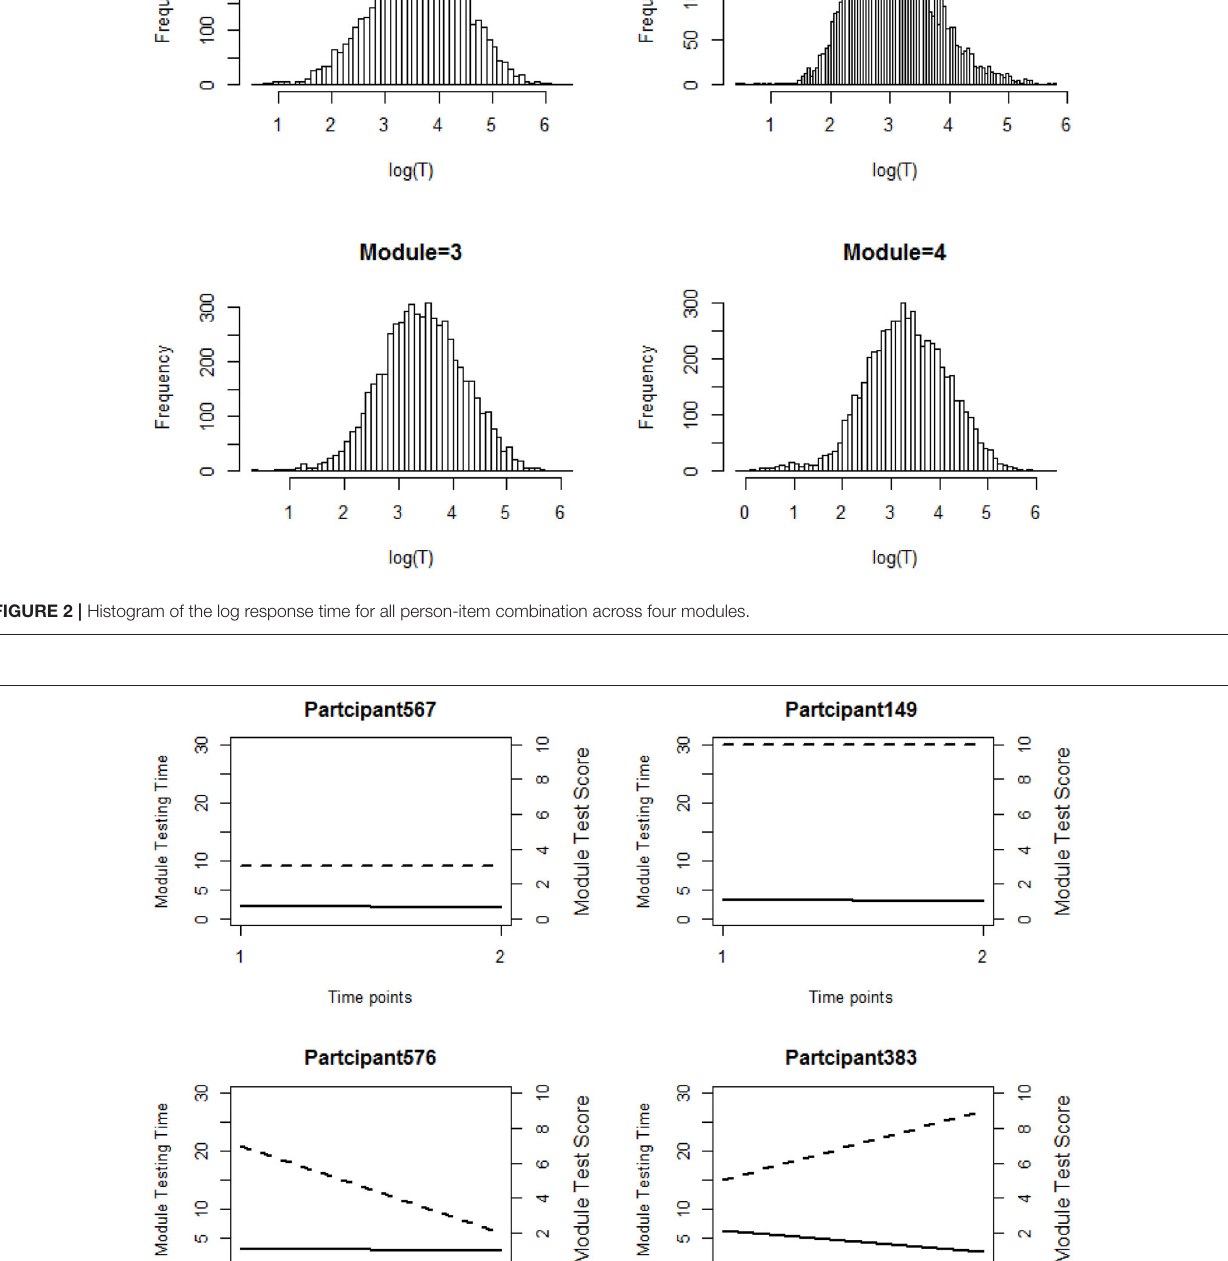
Frontiers in Psychology |